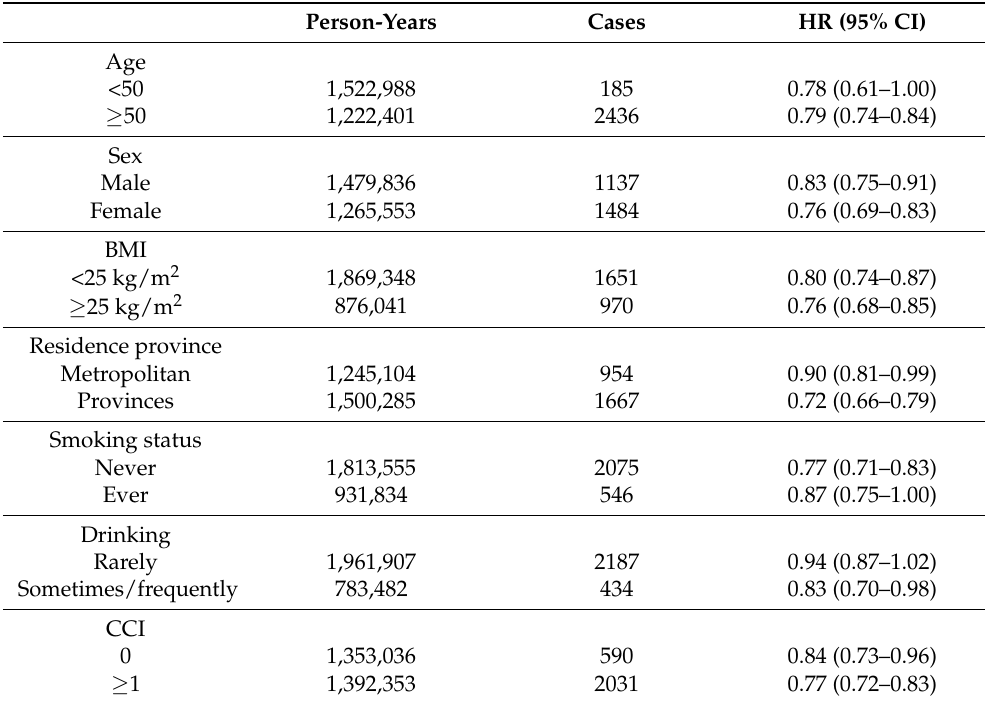
Table 4. Hazard ratios for association between long-term exposure to normalized difference vegetation index and Parkinson’s disease by age, BMI, residential province, and smoking per 0.1-unit